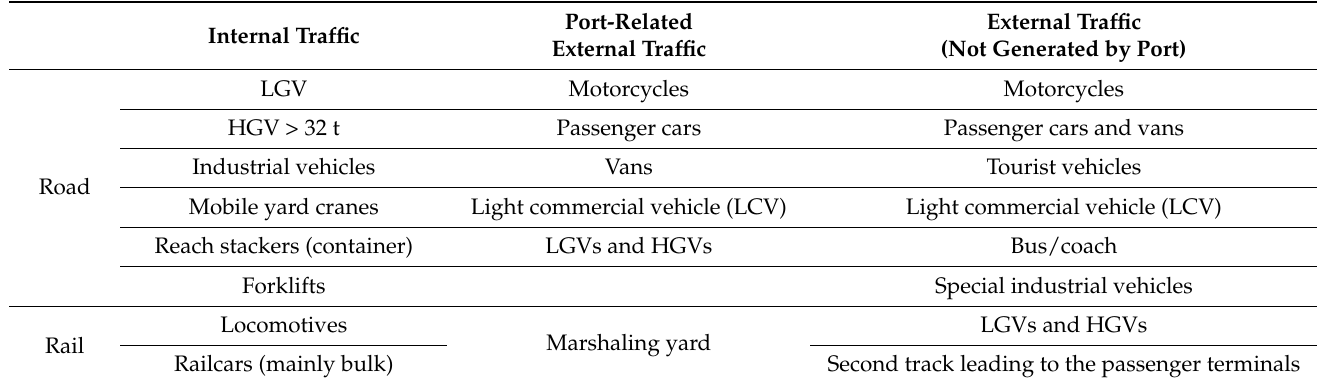
Table 5. List of the main road and rail traffic noise sources in the port of Split.